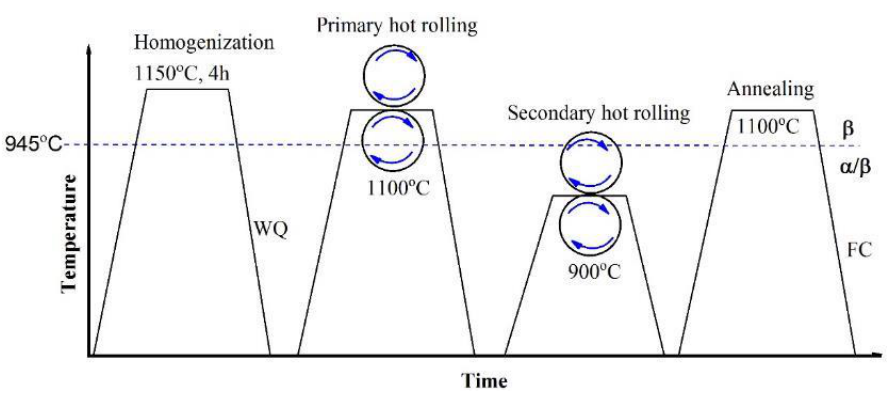
Fig. 1. The schematic illustration of thermomechanical route for achieving fully lamellar microstructure.